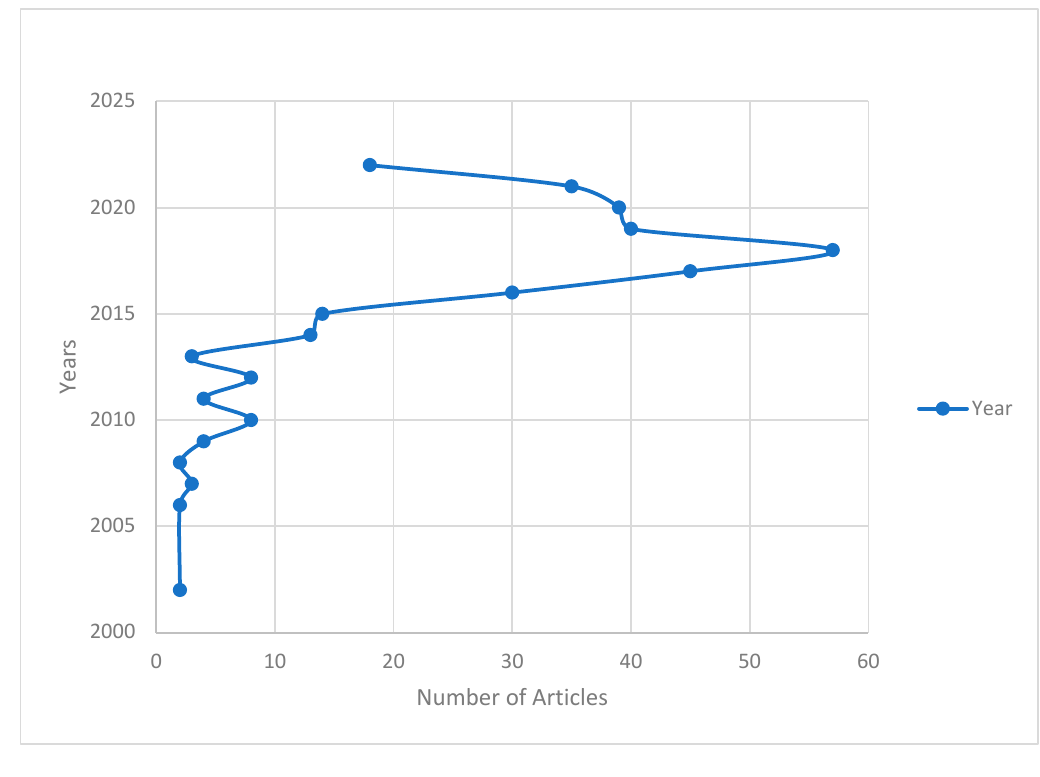
Figure 2. Annual scientific production.